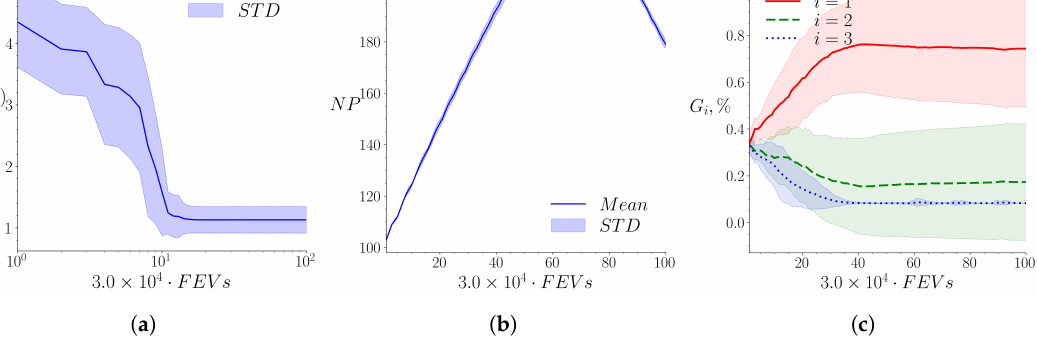
Figure A5. The dynamics of COSACC-LS1 on the F5 problem: ( a ) Convergence; ( b ) Population size; ( c ) Redistribution of resources.